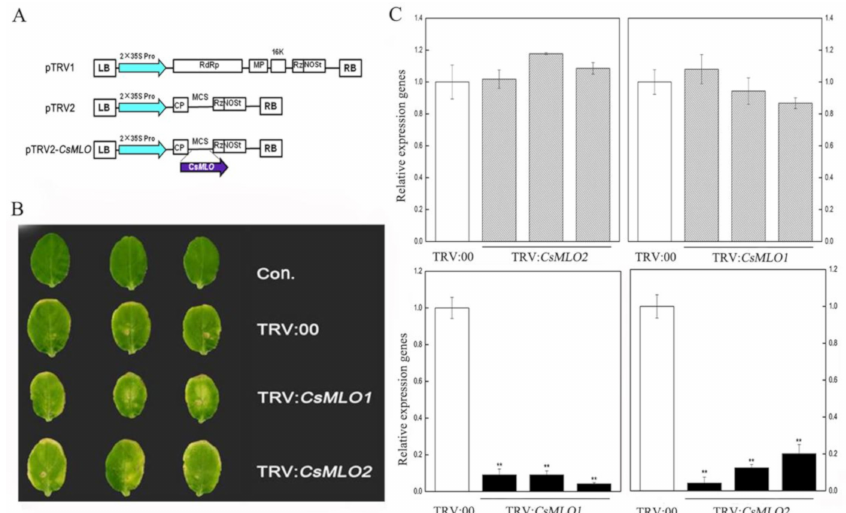
Figure 3. Identification of CsMLO -silencing cucumber plants. ( A ) Schematic of the CsMLO1- silenced and CsMLO2- silenced constructs. ( B ) Symptoms in detached cotyledons of silencing cucumber plants. Con. indicates non-injected plants. ( C ) CsMLO1- silenced and CsMLO2 -silenced were identified in transgenic plants by RT-qPCR. Black bars showed the e ffi cient silencing of CsMLO1 and CsMLO2 by RT-qPCR, and gray bars represented e ffi cient silencing of CsMLO2 in CsMLO1- silenced cucumber cotyledons and e ffi cient silencing of CsMLO1 in CsMLO2- silenced cucumber cotyledons. Data are means ± standard deviations from three independent experiments, and each column represents a sample containing three of cucumber cotyledons from di ff erent plants. Expression analysis of candidate genes using the 2 − ∆∆ Ct method. The asterisks indicated a significant di ff erence (Student’s t -test, *P < 0.05 or ** P < 0.01).